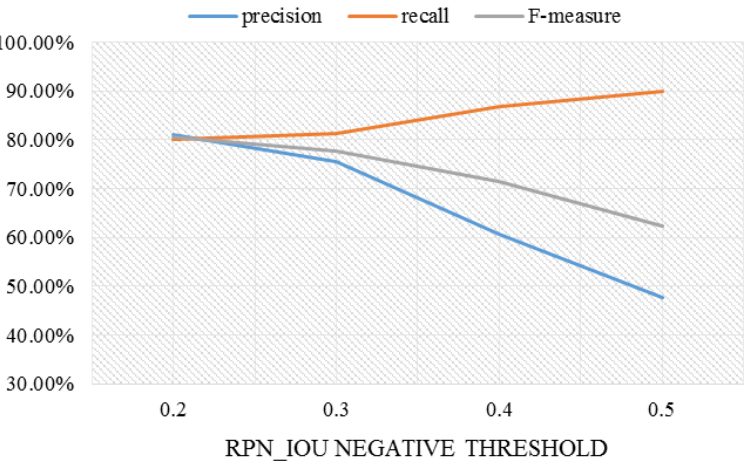
Figure 11. The results with the different RPN_IOU negative thresholds.